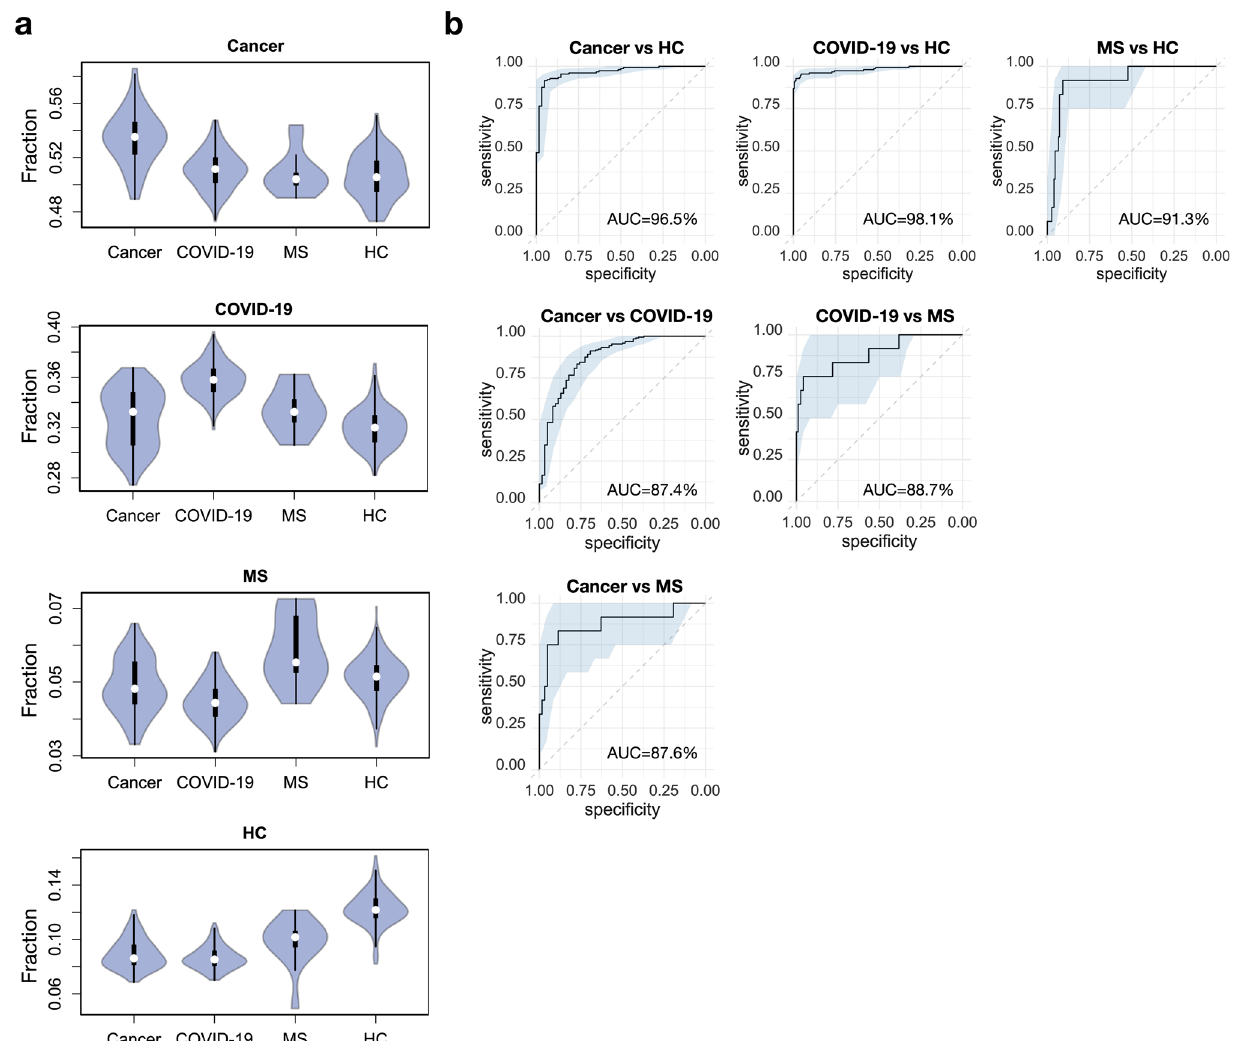
Fig. 5 Reference-based multiple disease classi fi cation of unseen TCR repertoire samples. a Violin plot showing the distribution of class fractions of cancer, COVID-19, multiple sclerosis (MS) patients and healthy controls (HC). Cancer fraction was calculated as the proportion of query TCRs clustered with reference TCRs from the cancer patients. Other class fractions were de fi ned in the same way. Sample size: HC: n = 153, COVID-19: n = 193, Cancer: n = 62, MS: n = 6. b ROC curves using disease class fractions as single predictor for pairwise separation of the four disease classes. The fraction was the percentage of TCRs co-clustered with a given class of samples in the reference dataset. AUC values were labeled at the bottom right of each panel. 95% con fi dence intervals were calculated using 2,000 strati fi ed